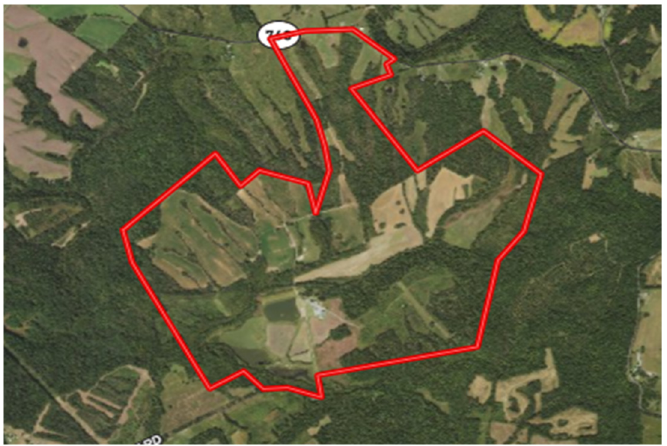
Figure 9. Property in Smithland Kentucky [30,34].